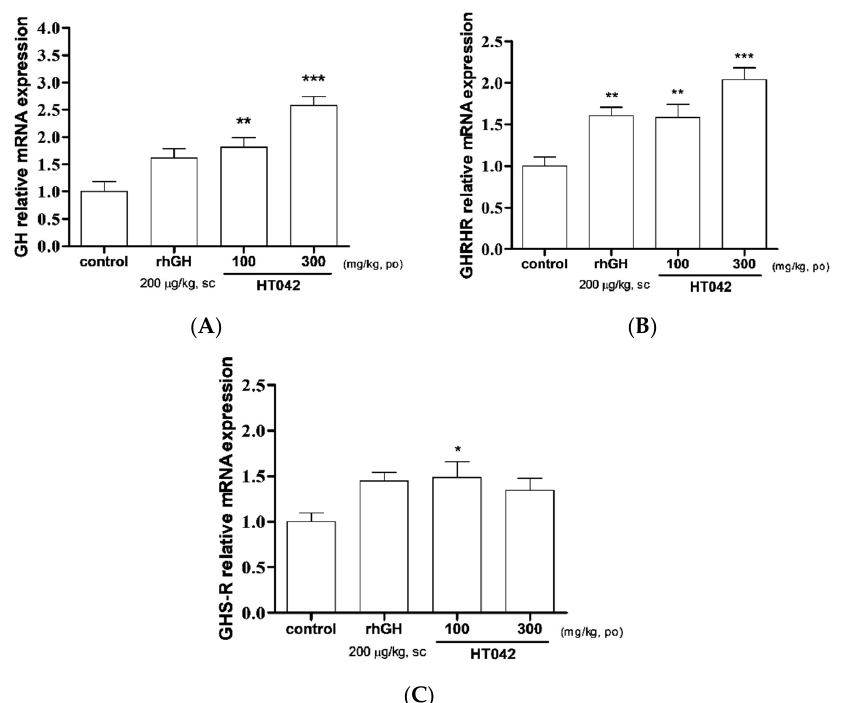
Figure 3. Relative expression of mRNA of ( A ) growth hormone, ( B ) growth hormone-releasing hormone receptor and ( C ) growth hormone secretagogue receptor in the pituitary measured by quantitative real-time quantitative polymerase chain reaction. Data are expressed as mean ± standard error. ( n = 8 per group), * p < 0.05, ** p < 0.01, *** p < 0.001.